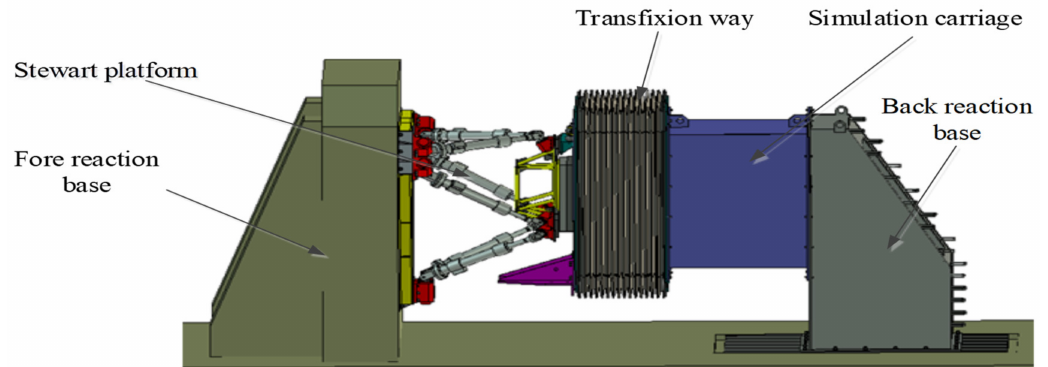
Figure 1. Comprehensive test system for train end